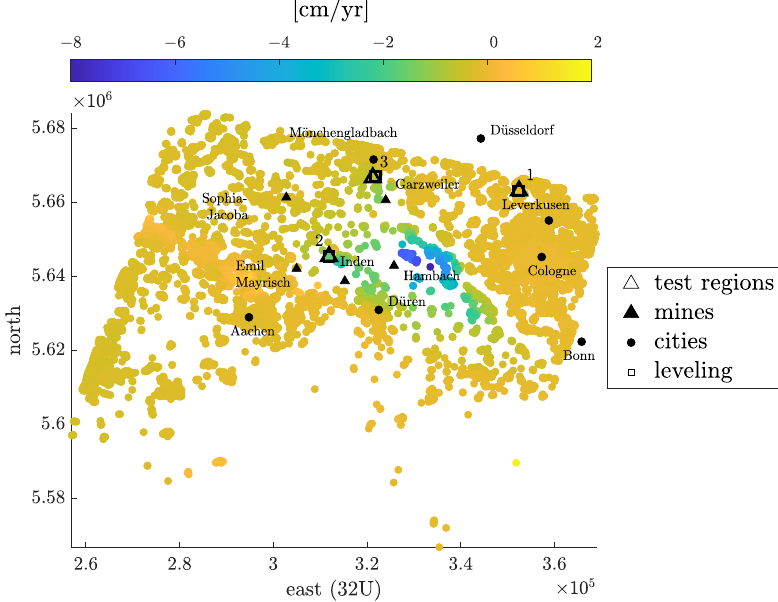
Figure 6. Mean deformation velocity map of the Lower-Rhine-Embayment based on ERS 1/2 data from May 1992 to December 2000 for pixels with a coherence value greater 0.7 in at least 95% of interferograms and estimated using the conventional EMCF approach. The highlighted test regions 1 to 3 are examined in more detail as time series in Figure